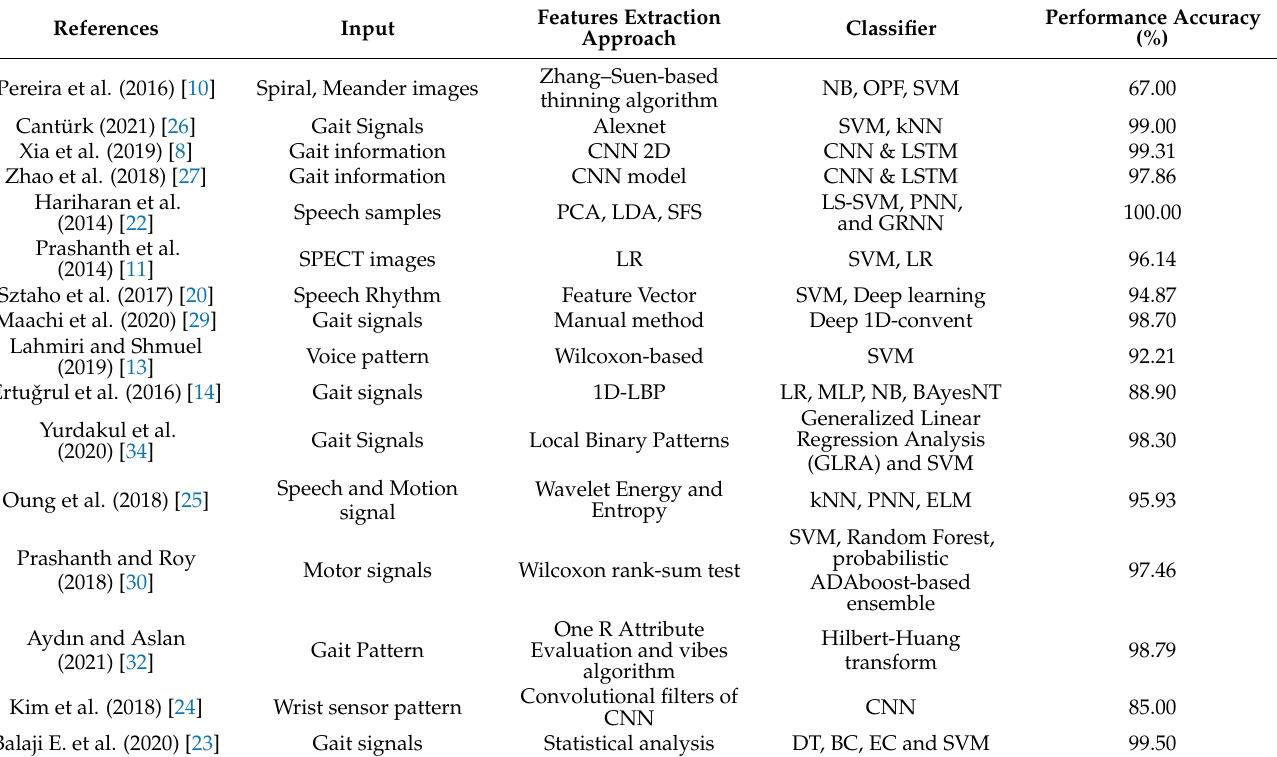
Table 1. Performance analysis of various Parkinson’s Disease (PD) identification